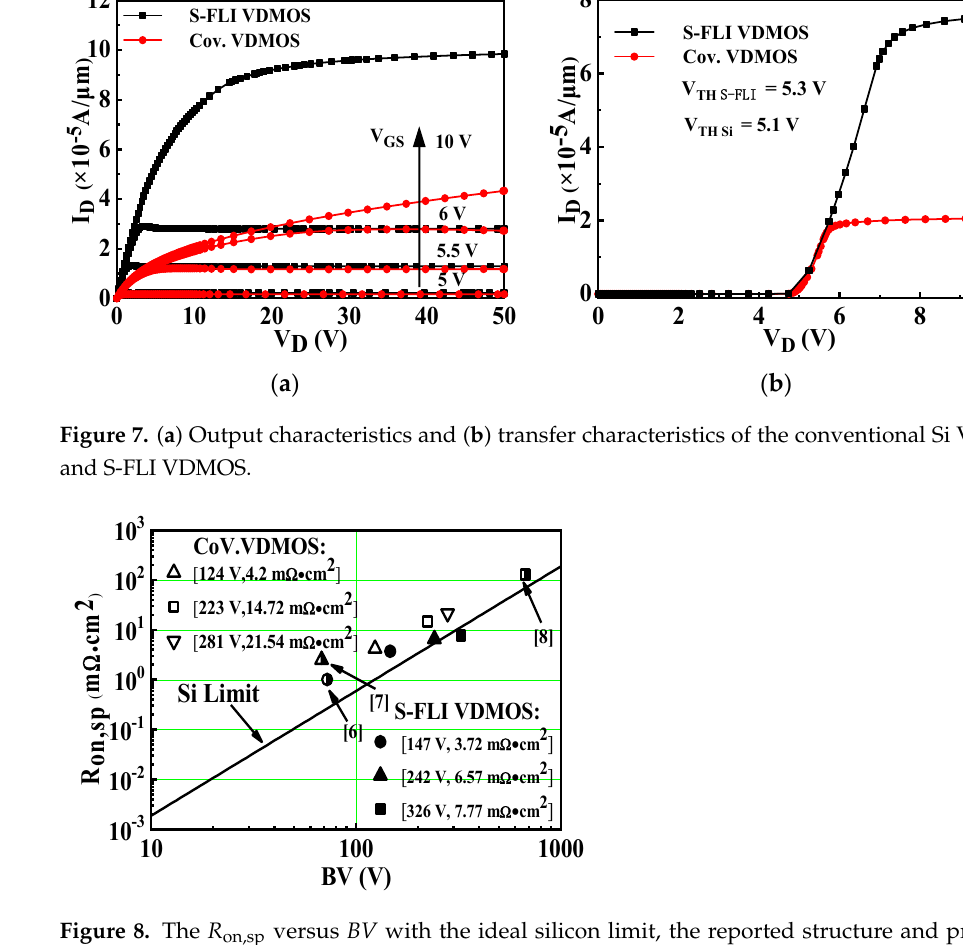
Figure 8. The R on,sp versus BV with the ideal silicon limit, the reported structure and proposed Si VDMOS.